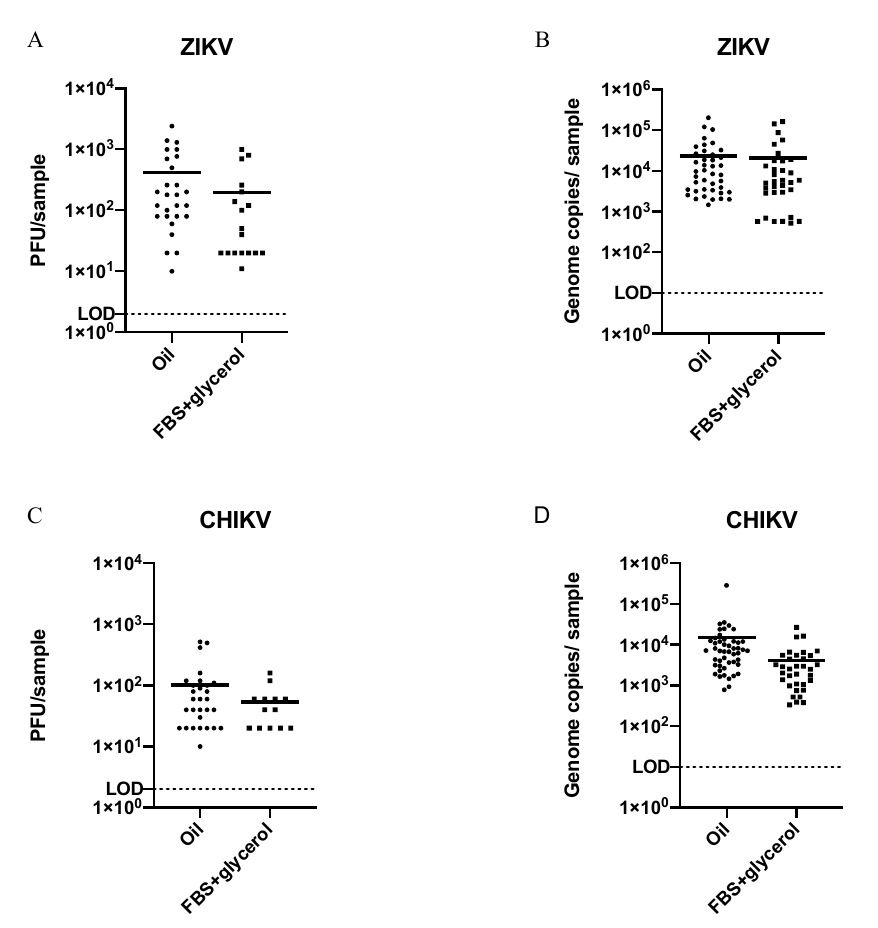
Figure 2. Quantification of virus and viral RNA from virus-positive forced salivations using oil or FBS-glycerol as the collection media; titer and genome copies of virus-positive saliva samples from individual mosquitoes infected with ZIKV ( A , B ) or CHIKV ( C , D ). LOD = limit of detection. Titer LOD = 2 PFU; genome copies LOD = 10. The means of virus titers or genome copies from saliva collected by either method (horizontal bars), regardless of virus, were not significantly different (un-paired t -test; p ≥ 0.05).